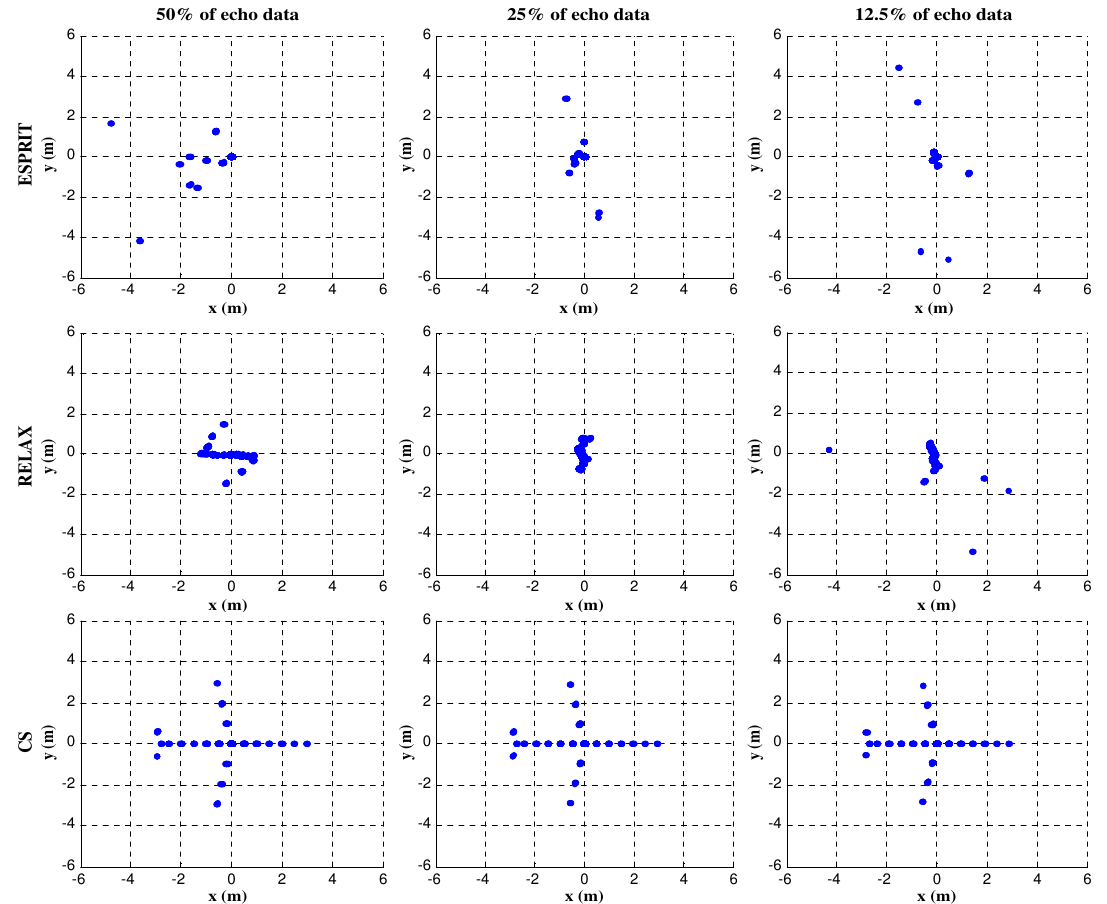
Figure 8. Passive ISAR imaging results with different reconstruction methods under different